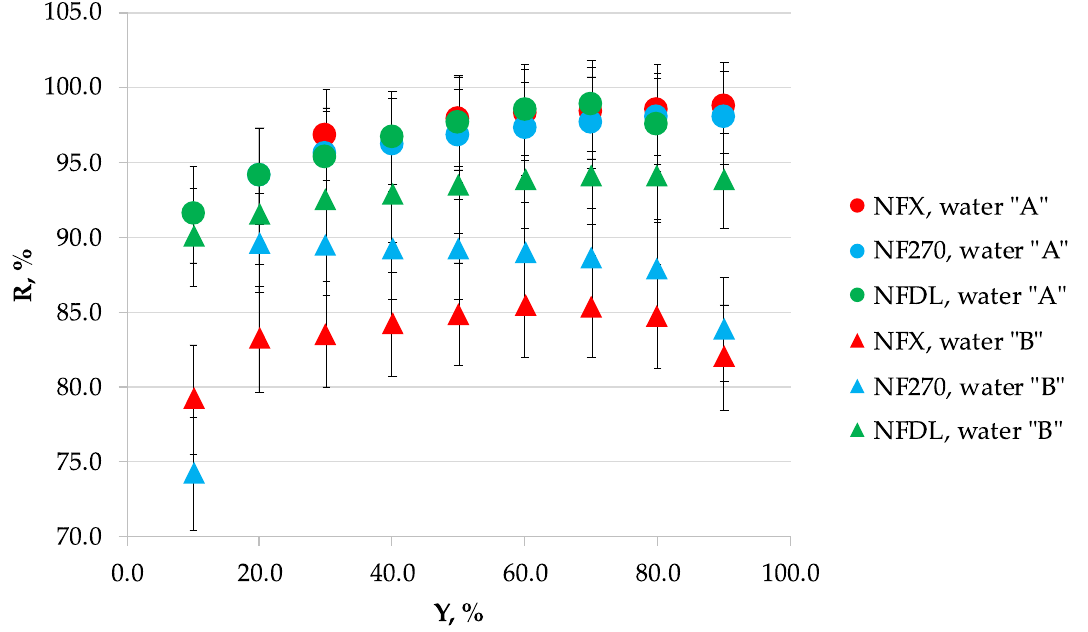
Figure A4. Rejection coefficient, R, of Mg 2+ ‐ as a function of permeate recovery, Y, for NFX, NF270 and NFDL nanofiltration membranes and mine waters “A” (0.384 g/L as Cl − , 1.02 g/L as SO 42 − , 0.107 g/L as Na + , 0.142 g/L as Mg 2+ , 0.312 g/L as Ca 2+ ) and “B” (33.2 g/L as Cl − , 0.937 g/L as SO 4 2 − , 19.5 g/L as Na + , 0.990 g/L as Mg 2+ , 0.771 g/L as Ca 2+ ).